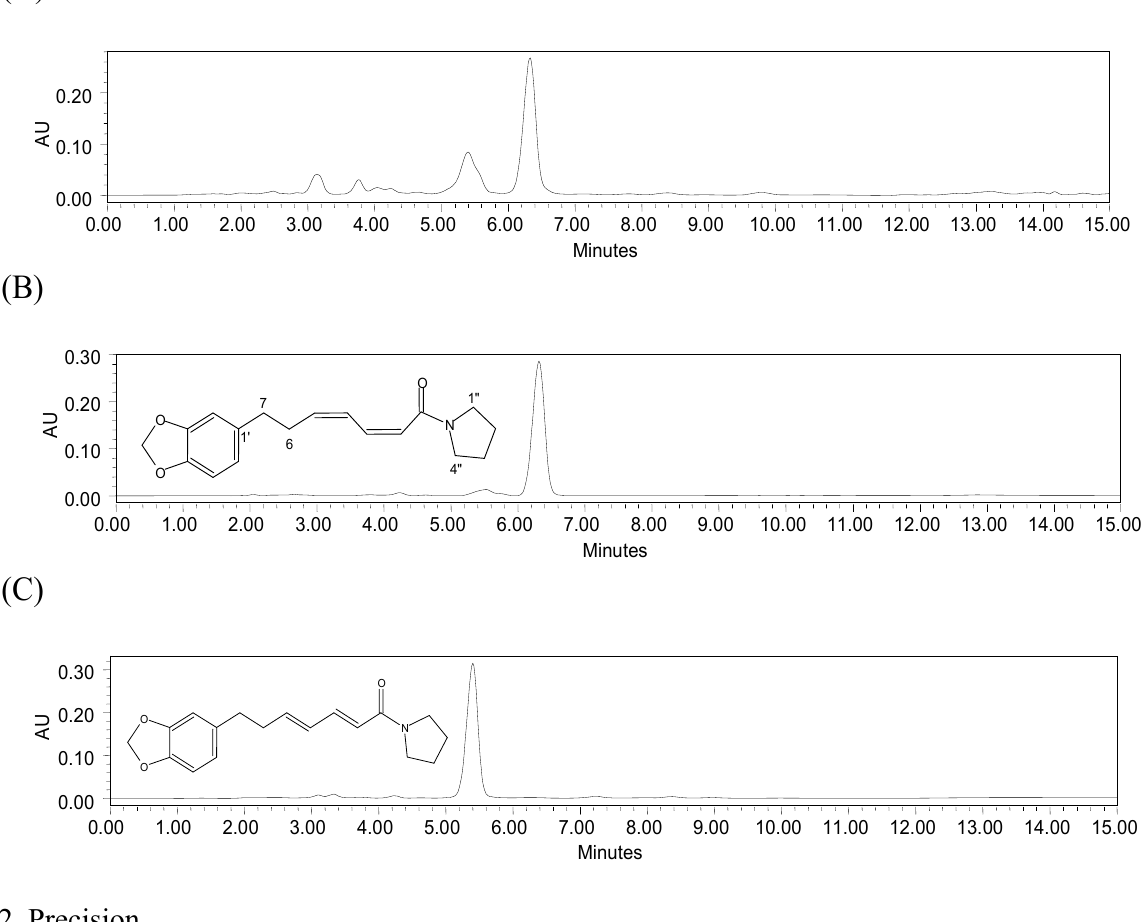
Figure 1. HPLC chromatograms of ( A ) chloroform leaf extract of P. amalago L.; ( B ) compound ( 1 ) (R = 6.3 min) and ( C ) compound ( 2 ) (R = 5.4 min). Chromatographic t t conditions: YMC Pack Pro C18 column; mobile phase: acetonitrile-water (with 1% acetic acid) (58:42 v/v) for 10 min, and 100% of acetonitrile from 11 to 15 min; flow rate 1 mL/min; temperature 298 K; detection at 260